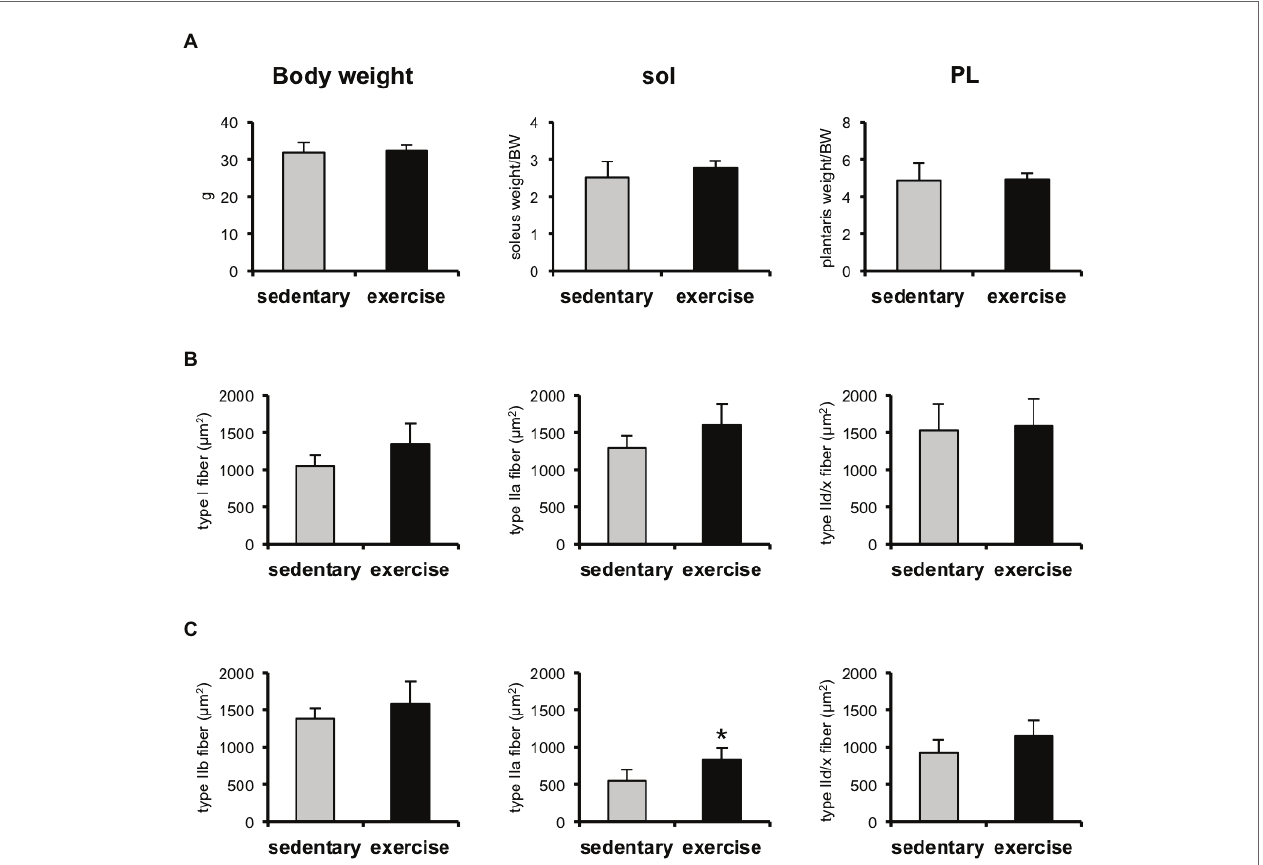
FIGURE 4 | Skeletal muscle weights and cross-sectional areas (CSAs) of skeletal muscles in aged sedentary and aged exercised mice. (A) Bodyweight and soleus (sol) and plantaris (PL) muscle weights of aged sedentary ( n = 4) and aged exercised mice ( n = 6). (B) CSAs of type I, IIa, and IId/x in soleus muscles of aged sedentary ( n = 4) and aged exercised mice ( n = 6). (C) CSAs of type IIb, IIa, and IId/x in plantaris muscles of aged sedentary ( n = 4) and aged exercised mice ( n = 6). Data are presented as means ± SD. * p < 0.05 vs. the sedentary